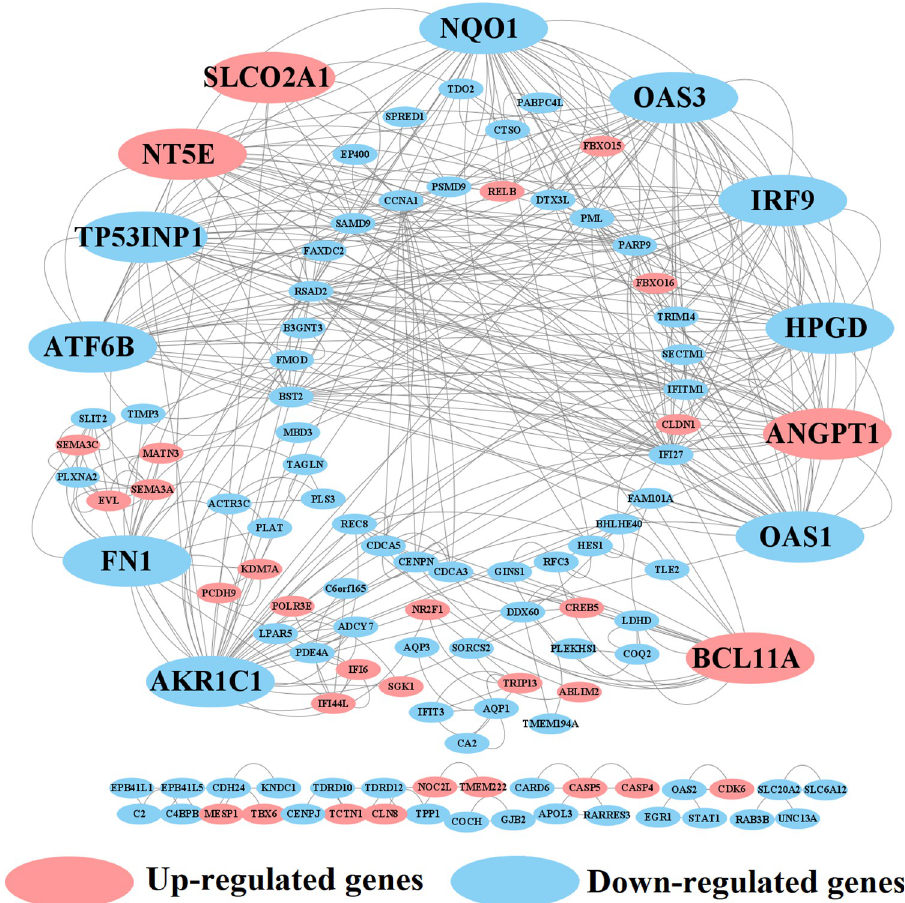
Fig 3. Protein-protein interaction (PPI) network of DEGs to select the key genes (KGs). Blue color indicates downregulated and pink color indicates upregulated DEGs, big size and octagon shape indicate the KGs. indicates up regulated and blue color indicates down regulated DEGs, big size and octagon shape indicate KGs (see Fig 3 ). We used five topological measures (Degree, BottleNeck, Betweenness, Stress and Clustering Coefficient) to select top-ranked 13 KGs that are AKR1C1 , IRF9 , OAS1 , OAS3 , SLCO2A1 , NT5E , NQO1 , ANGPT1 , FN1 , ATF6B , HPGD , BCL11A , and